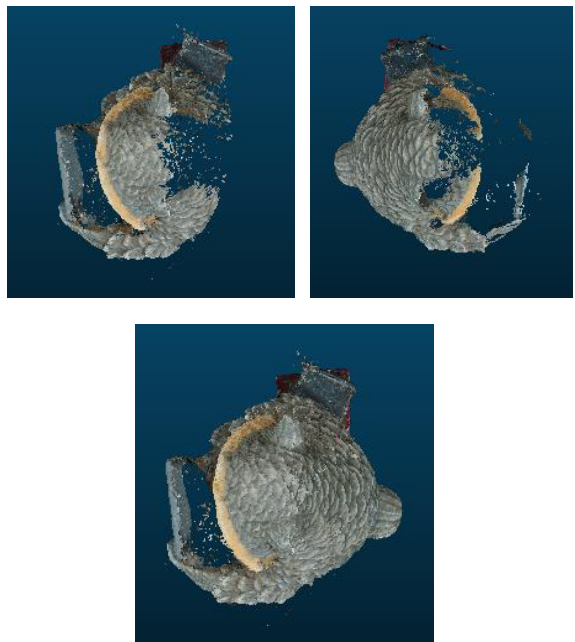
Figure 4: Point cloud before and after transformation. Image Based Modelling case study (Kontogianni et al. 2018)